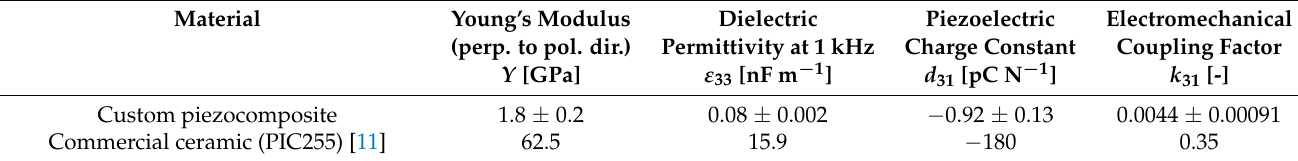
Table 1. Properties of the piezoelectric materials under investigation.